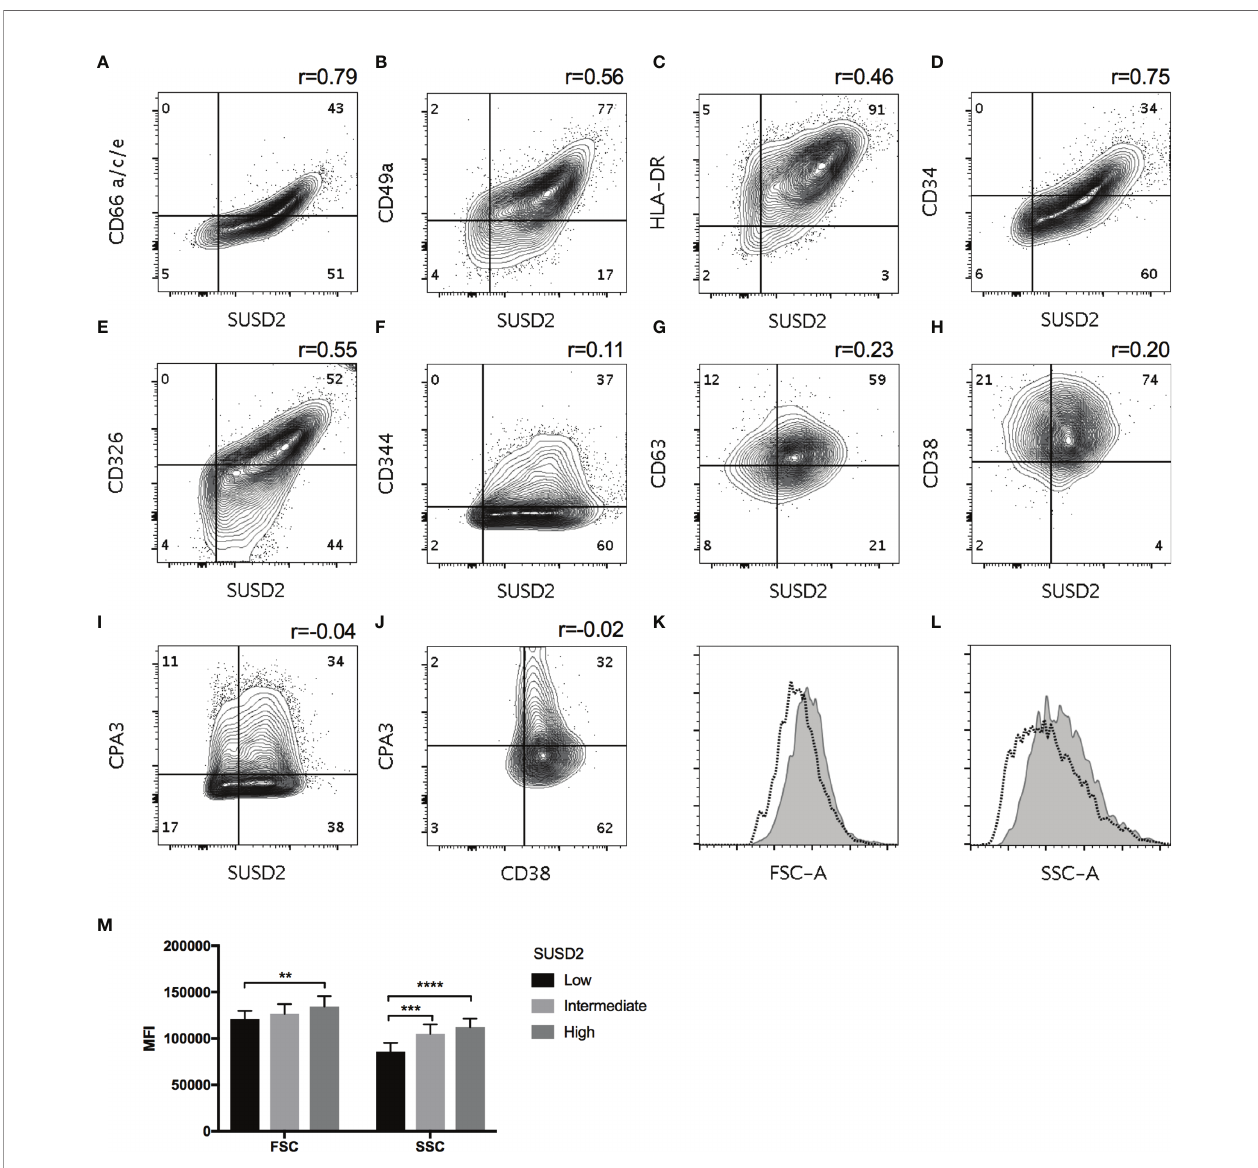
FIGURE 4 | Co-staining of HLMCs with indicated markers. Pearson correlations in each donor was calculated and the average r is shown (n = 3-4) (A – J) . SUSD2low, intermediate and high cells were gated, and the FSC (K) and SSC (L) values of the SUSD2low (dotted line) and SUSD2high ( fi lled gray) populations are shown. Quanti fi cation of FSC and SSC is shown in (M) , mean ± SEM, n = 5. Two-way ANOVA with Bonferroni ’ s multiple comparisons test was performed. **p < 0.01; ***p < 0.001; ****p <